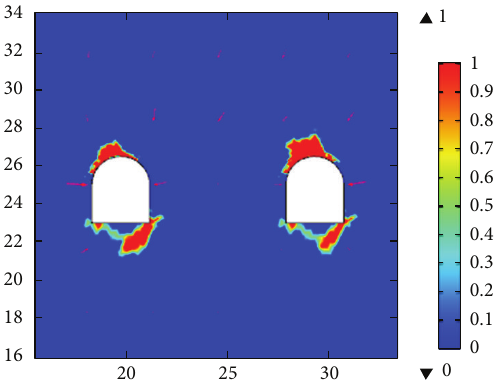
Figure 22: Damage zone of the simulating model (the direction of damage zone is approximately perpendicular to that of the joint planes whose angle is 15 ∘